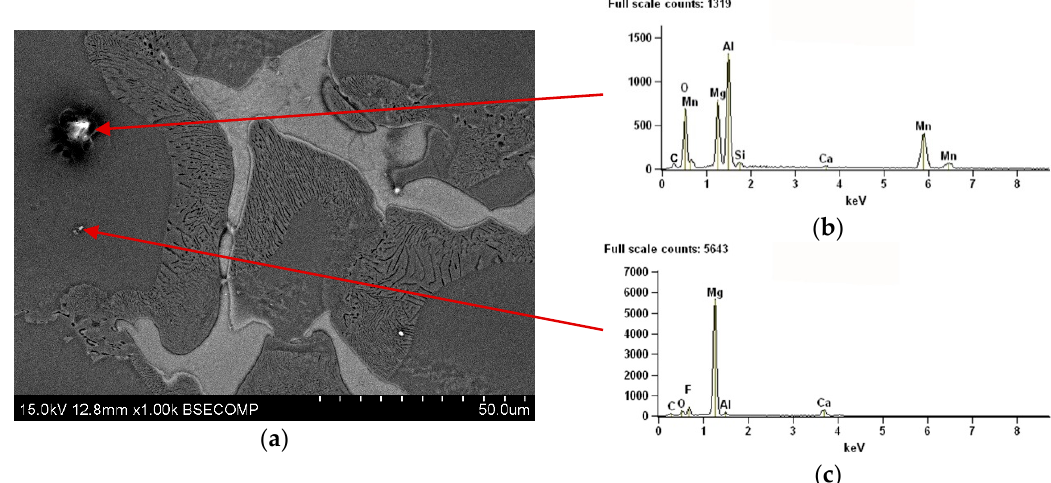
Figure 8. Precipitates containing carbon and calcium in alloy after modification with wax-CaF 2 -carbon powder: ( a ) SEM, ( b,c ) EDS.